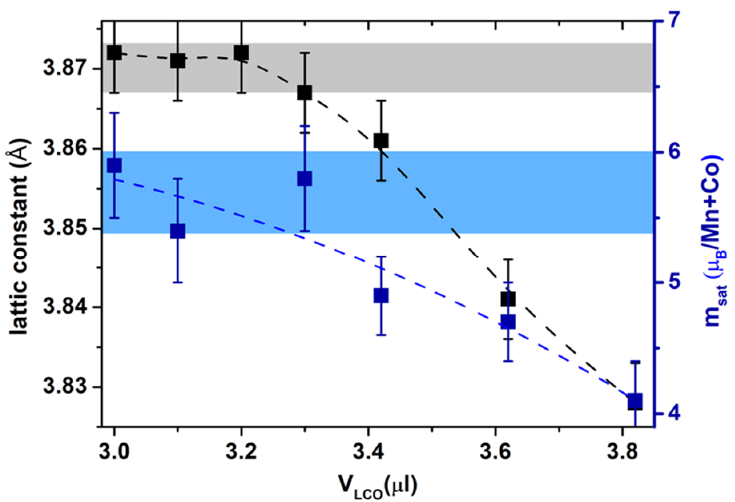
Figure 11. Impact of deposition volume V LCO on the lattice constant and the saturation magnetization of LCO/LMO SL grown by Layer-by-Layer